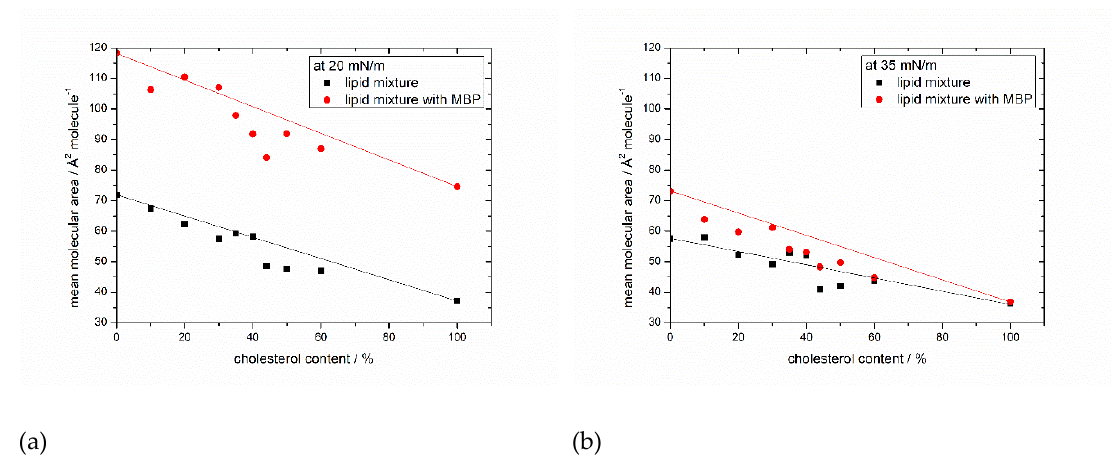
Figure 3. Surface area in dependency of the cholesterol content. Surface areas of lipid monolayer with (red) and without MBP (black) taken from the isotherms of Figures 1 and 2 at surface pressures of ( a ) 20 mN/m and ( b ) 35 mN/m. Straight lines indicate the theoretical ideal mean molecular surface areas.